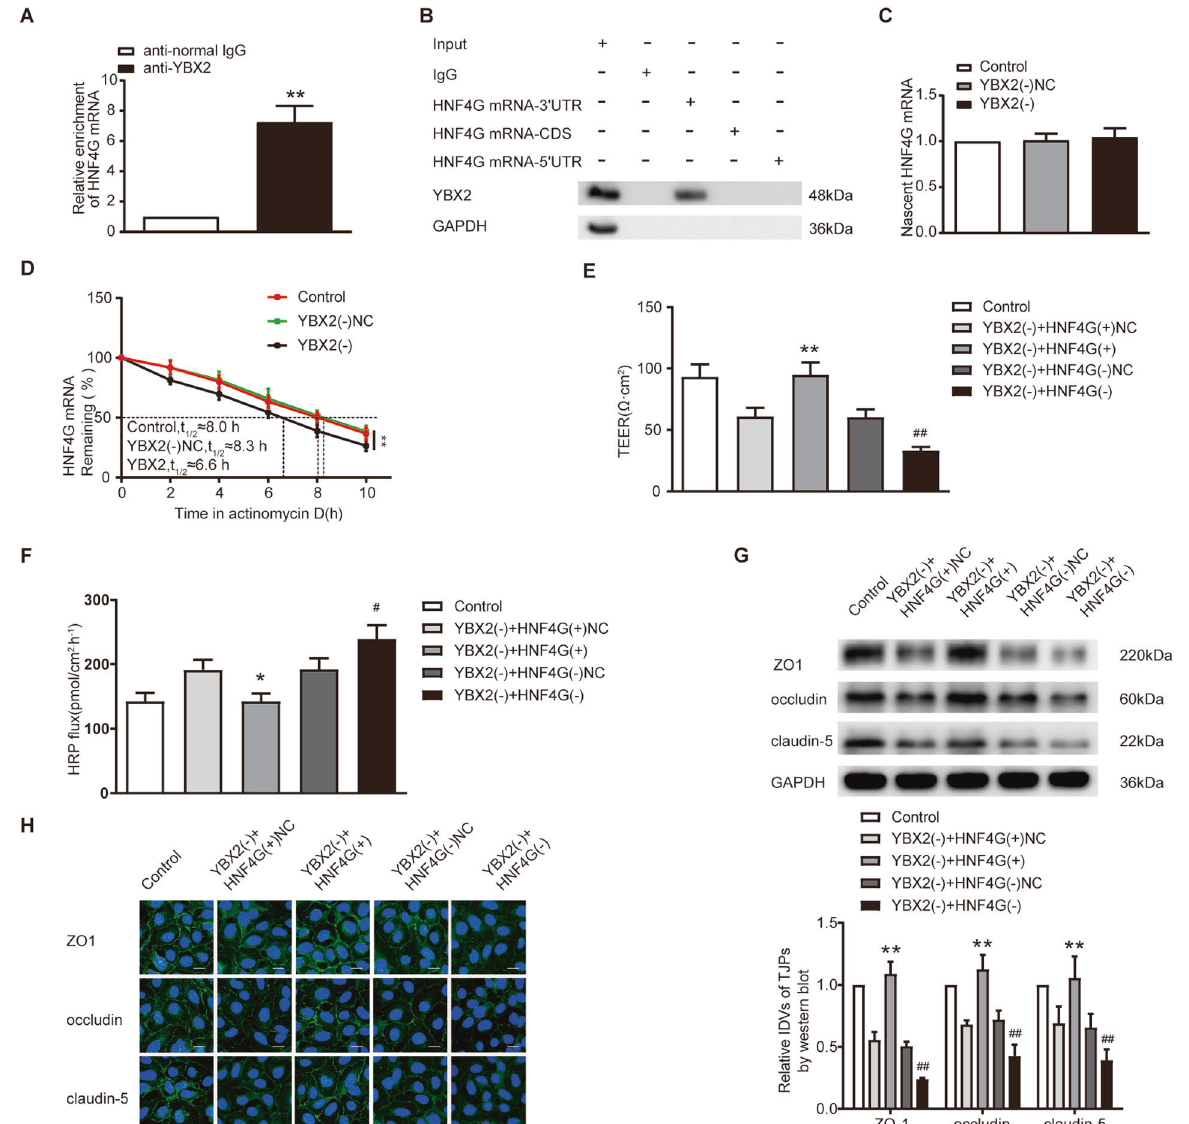
Fig. 6 Knockdown of YBX2 decreased HNF4G stability, and HNF4G participated in the process of YBX2 regulating BTB permeability. A Enrichment of HNF4G mRNA in anti-YBX2 immunoprecipitates was measured by RIP assay. Relative enrichment of HNF4G mRNA was measured using qRT-PCR. Data represent mean ± SD ( n = 3, each). ** P < 0.01 vs. anti-normal IgG group. B RNA pull-down assay con fi rmed that YBX2 bound to HNF4G mRNA. YBX2 and GAPDH protein levels in immunoprecipitates with HNF4G mRNA were evaluated by western blot. C Nascent HNF4G mRNA was labeled and captured by nascent RNA capture assay. No signi fi cant difference of HNF4G mRNA was found in YBX2 knockdown GECs. D Knockdown of YBX2 decreased the half-life of HNF4G mRNA. Data represent mean ± SD ( n = 3, each). ** P < 0.01 vs. YBX2(-)NC group. E , F Effects of YBX2 and HNF4G on TEER value and HRP fl ux. * p < 0.05 vs. YBX2(-) + HNF4G( + )NC group, ** p < 0.01 vs. YBX2(-) + HNF4G( + )NC group, # p < 0.05 vs. YBX2(-) + HNF4G(-)NC group, ## p < 0.01 vs. YBX2(-) + HNF4G(-)NC group. G Effects of YBX2 and HNF4G on the expression levels of ZO-1, occludin and claudin-5 determined by western blot. Data represent mean ± SD ( n = 3, each group). ** p < 0.01 vs. YBX2(-) + HNF4G( + )NC group, ## p < 0.01 vs. YBX2(-) + HNF4G(-)NC group. H Effects of YBX2 and HNF4G on ZO-1, occludin and claudin-5 expression levels and distribution determined by immuno fl uorescence. Scale bar represents 30 μ